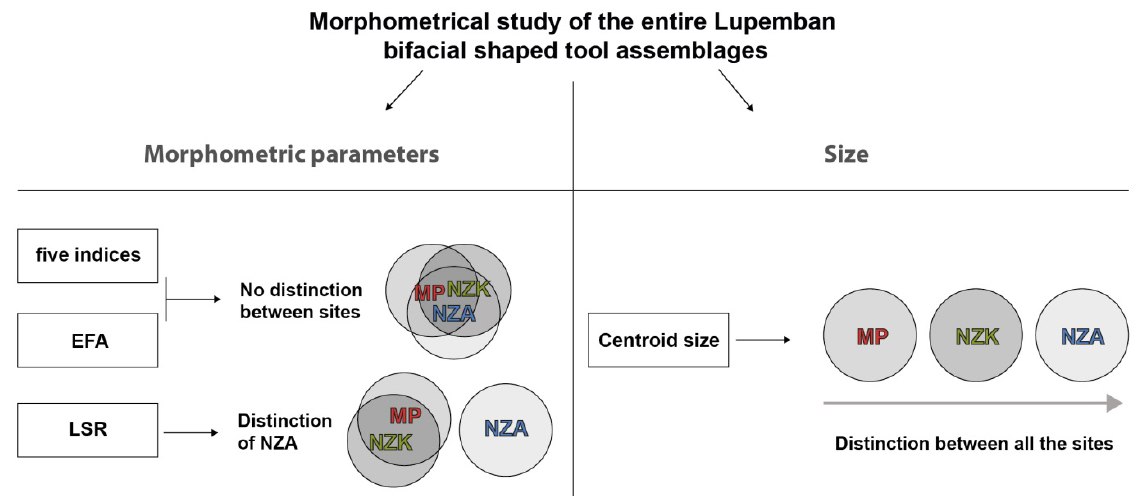
Figure 20. Summary of the results obtained with the different approaches (five indices, EFA, LSR) on the entire